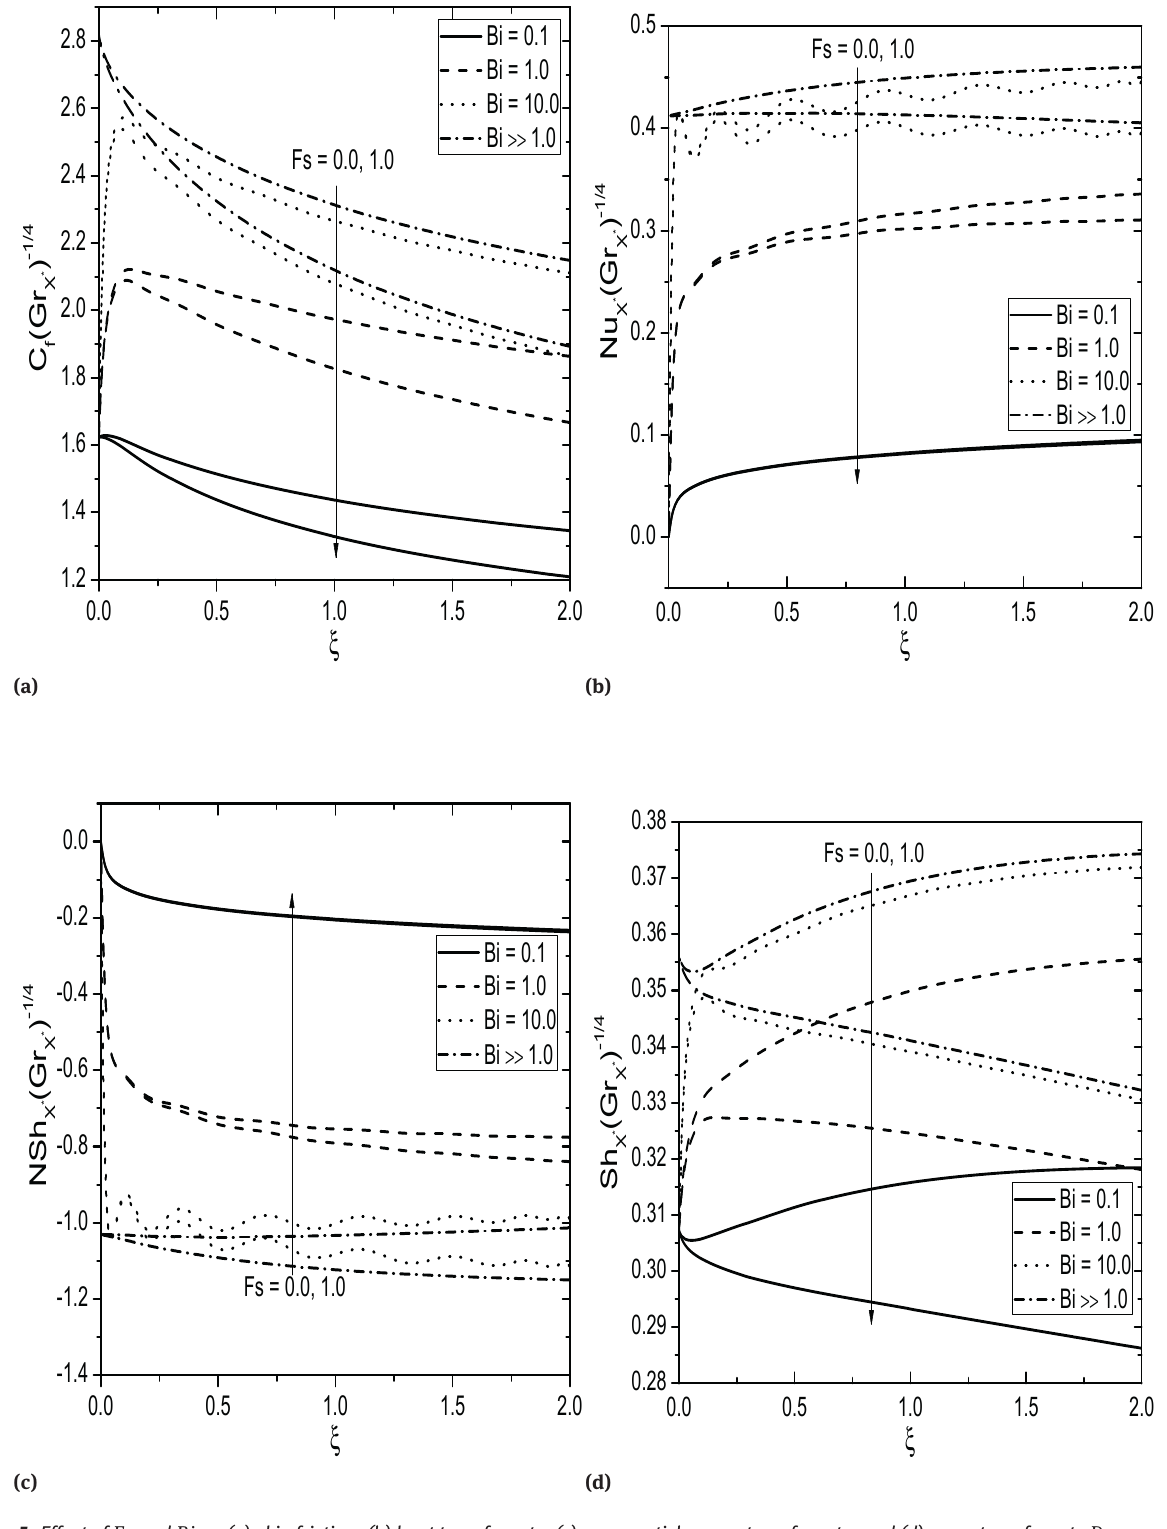
Fig. 5: Effect of Fs and Bi on (a) skin friction, (b) heat transfer rate, (c) nanoparticle mass transfer rate, and (d) mass transfer rate Ds = 0.2, Dc = 0.3